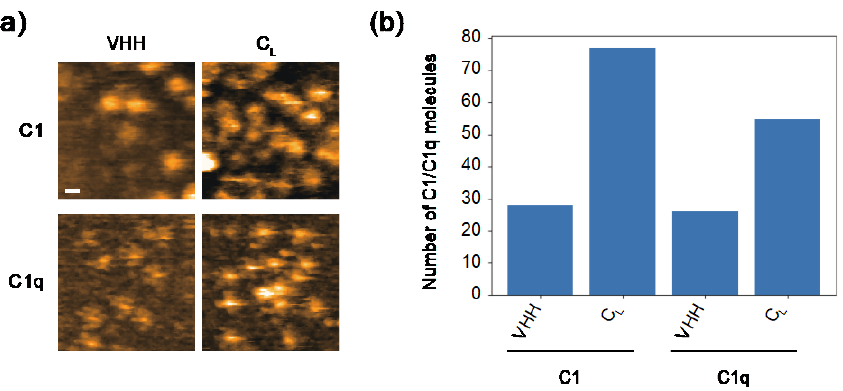
Figure 4. HS-AFM observation of the interaction of C L /VHH with C1/C1q. ( a ) Typical HS-AFM images of C1 and C1q observed on C L - or VHH-covered mica surfaces. Scale bar = 20 nm. ( b ) The number of C1/C1q observed on the C L - or VHH-covered mica surface.